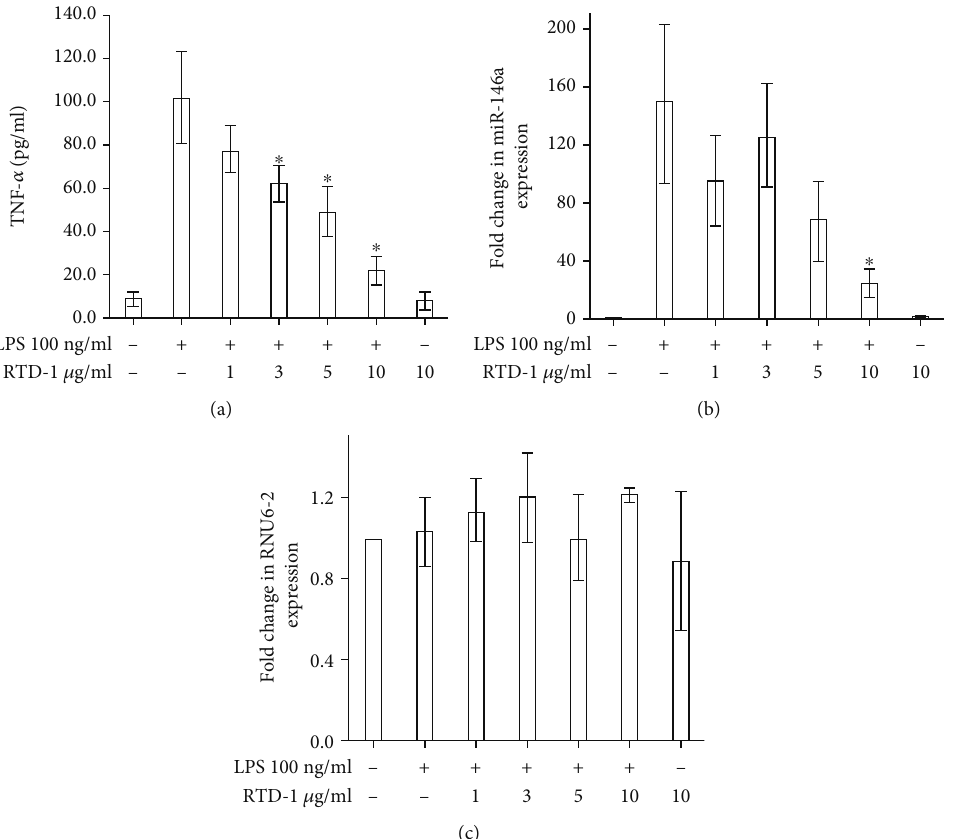
Figure 1: RTD-1 inhibits expression of miR-146a in LPS-stimulated cells. THP-1 cells were treated with 100ng/ml LPS and RTD-1 at the indicated concentrations for 20 h. The medium was analyzed by TNF- α ELISA (a), and the RNA was analyzed by qRT-PCR for expression of miR-146a (b), and RNU6-2 (c) after normalizing to SNORD68 expression. Data shown are the results of 3 experiments; ∗ P < 0 : 05 compared to LPS treatment, two-tailed, paired t test. Fold change was calculated with respect to vehicle-treated control in (b) and (c).